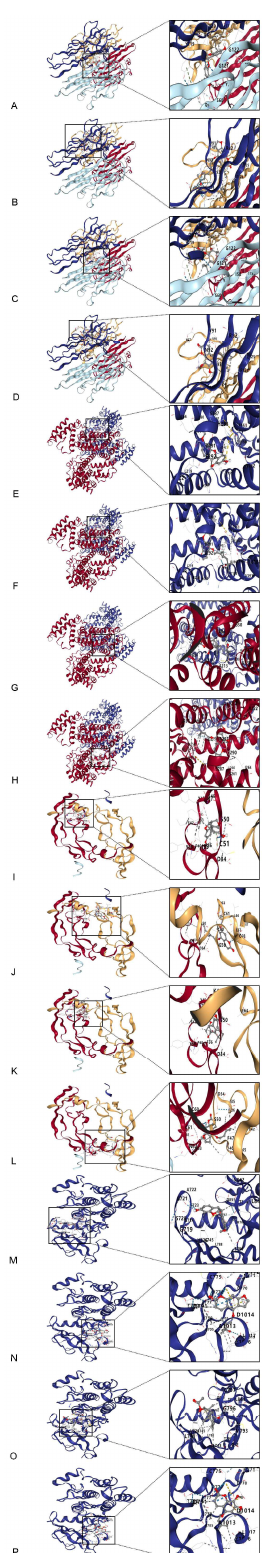
Figure 7. Simulation maps of docking. ( A – D ) TNF- α docking medicarpin, notoptol, vitetri- folin E, cnidilin; ( E – H ) ALB docking medicarpin, notoptol, vitetrifolin E, cnidilin; ( I – L ) VEGFA docking medicarpin, notoptol, vitetrifolin E, cnidilin; ( M – P ) EGFR docking medicarpin, notoptol, vitetrifolin E,